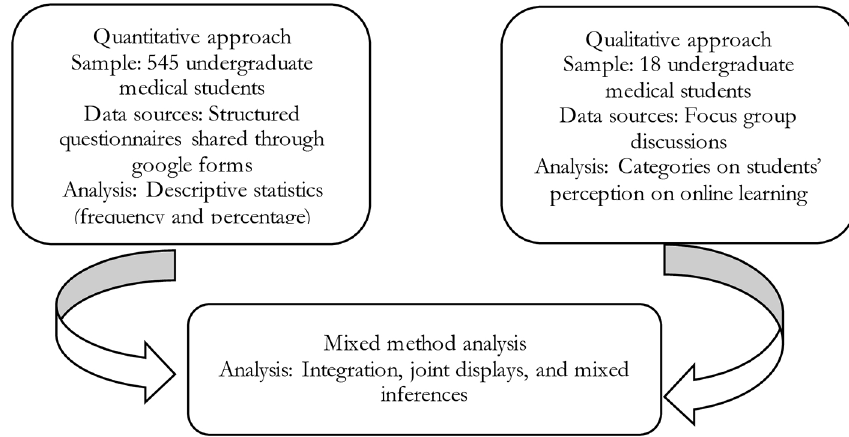
Figure 1. Schematic representation of research